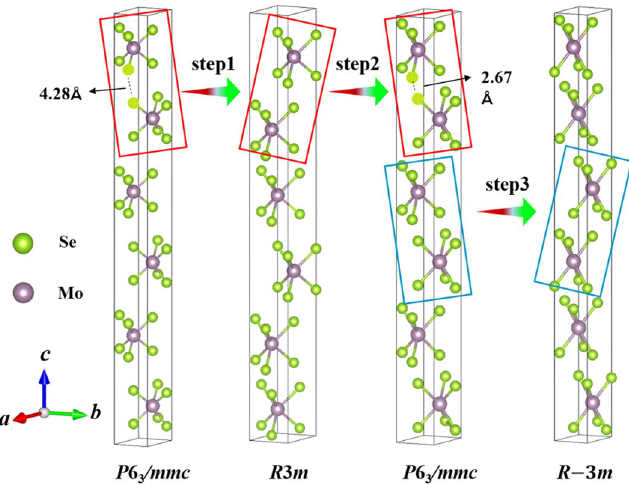
Figure 5. The schematic diagram of four phases of MoSe 2 under different pressures in the pressure range of 0 GPa to 500 GPa. ( a ) 1 × 1 × 3 supercell for P 6 3 /mmc phase at 0 GPa, ( b ) 1 × 1 × 2 supercell for R 3 m phase at 20 GPa, ( c ) 1 × 1 × 3 supercell for P 6 3 /mmc at 80 GPa, and ( d ) 1 × 1 × 2 supercell for R -3 m phase at 500 GPa,